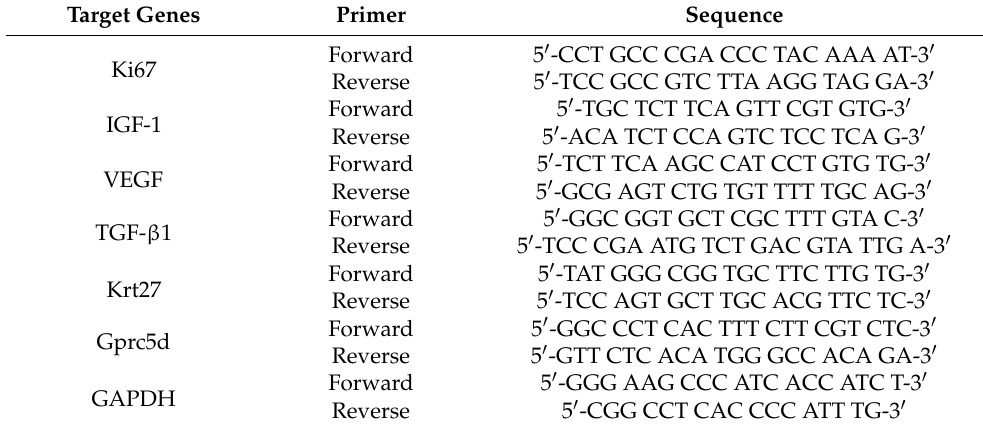
Table 2. Primer pairs used for